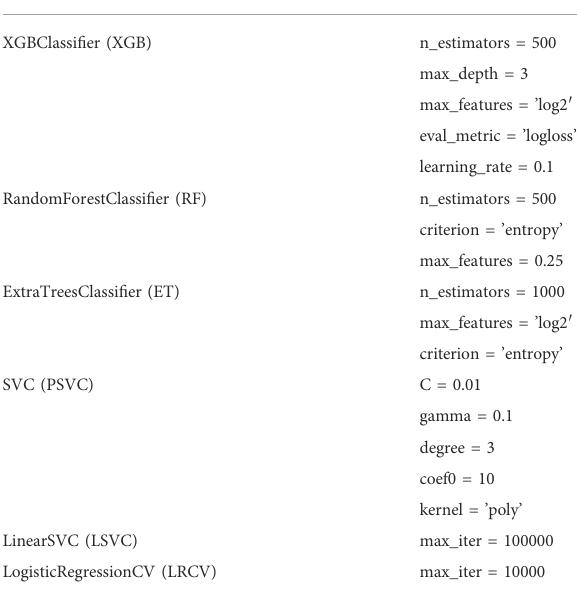
TABLE 2 Machine learning models used, and their parameters. Parameters that are not in the table were set to the default values of the SciKit-Learn (version 1.0.2)